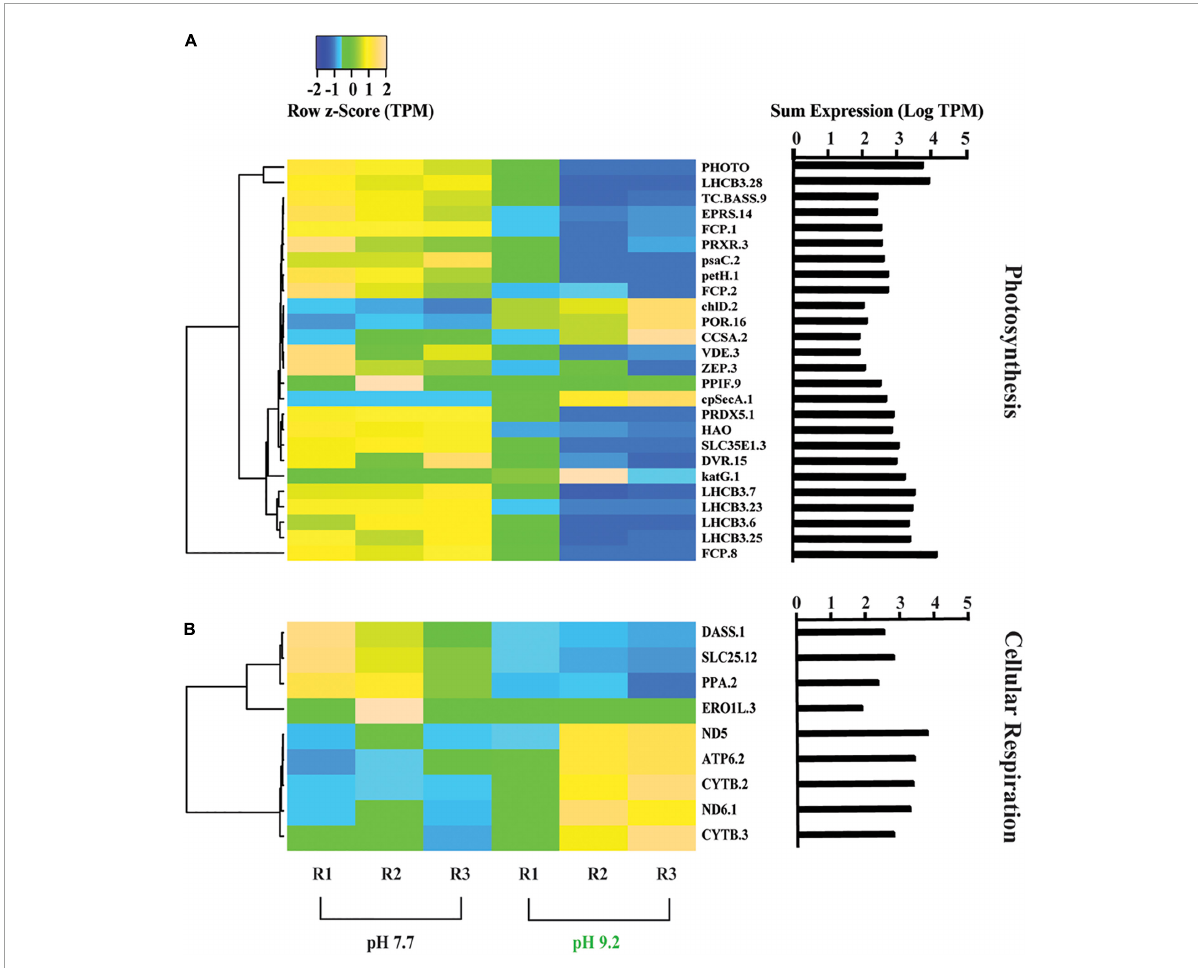
FIGURE3 Heat map depicting differentially expressed genes relating to energy production and conversion. (A) Genes further sorted into photosynthesis and (B) cellular respiration categories. All TPM values were row z-scored, with increases in proportional transcript abundance indicated in yellow, and decreases in proportional transcript abundance indicated in blue. Cladogram clustering is to demonstrate similarity in expression. The sum of transcripts across all treatments (LogTPM) is indicated for each